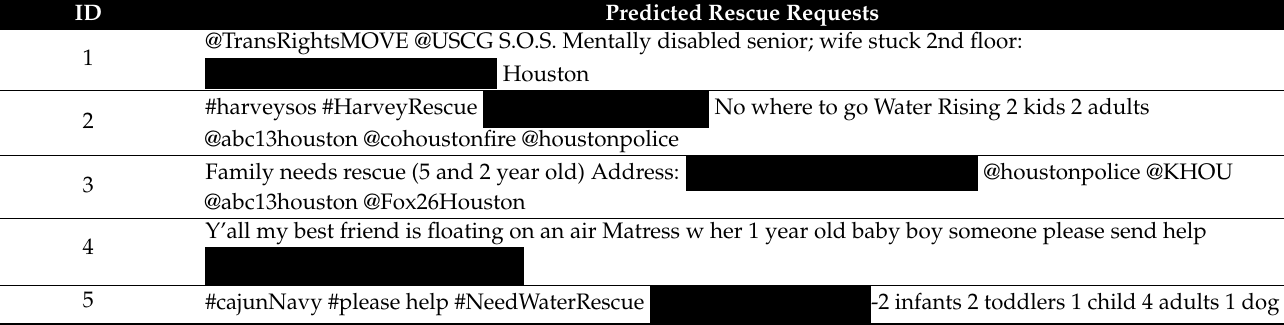
Figure 6. Model evaluation results after applying trained classifiers to test data. Table 1. Examples of predicted rescue requests.